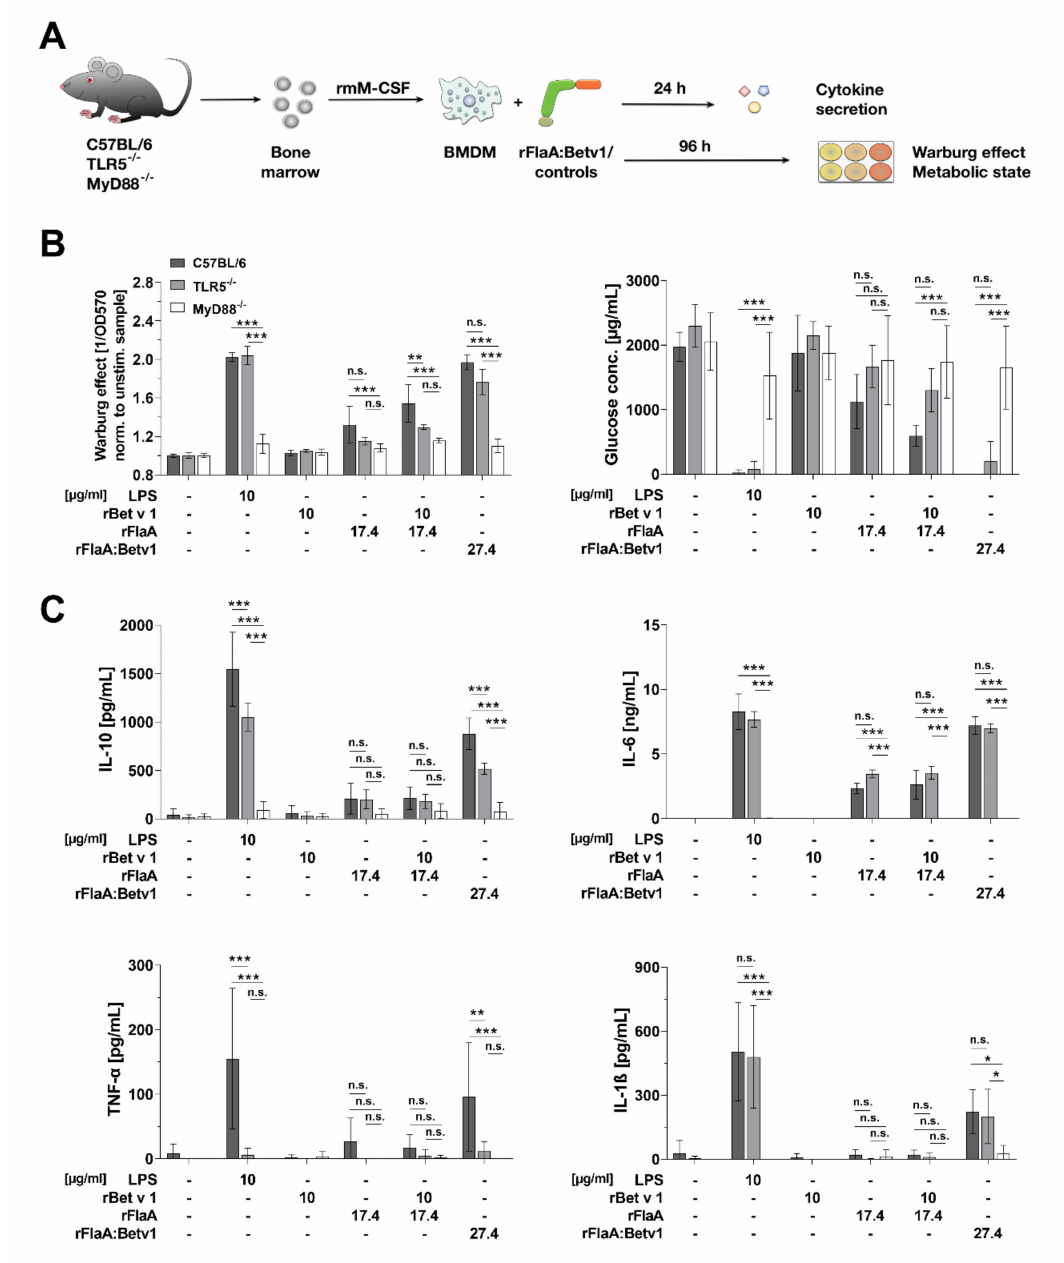
Figure 3. rFlaA:Betv1-induced BMDM metabolism and inflammatory cytokine secretion depend on MyD88 while being only partly TLR5-dependent. C57BL/6, TLR5 − / − , or MyD88 − / − BMDMs were differentiated from mouse bone marrow and stimulated with the indicated equimolar protein amounts or LPS as a positive control for either 24 h (cytokine secretion, C ) or 96 h (metabolic state, B ) ( A ). Supernatants were analyzed for the induced Warburg effect and glucose consumption ( B ) as well as cytokine secretion by ELISA ( C ). Data are mean results of three independent experiments ± SD with two technical replicates per experiment. Statistical significance indicated as: n.s. p -value > 0.05, * p -value < 0.05, ** p -value < 0.01, *** p -value <